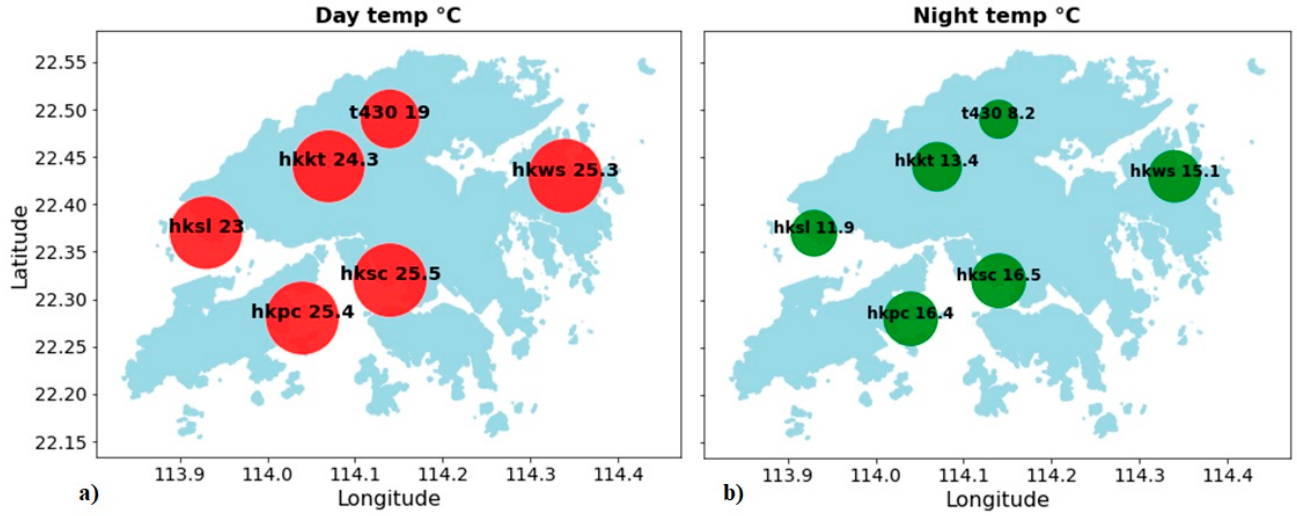
Figure 2. ( a ) Average temperatures derived from GPS data during the day in the summer. ( b ) Average temperatures derived from GPS data during the night in the summer.